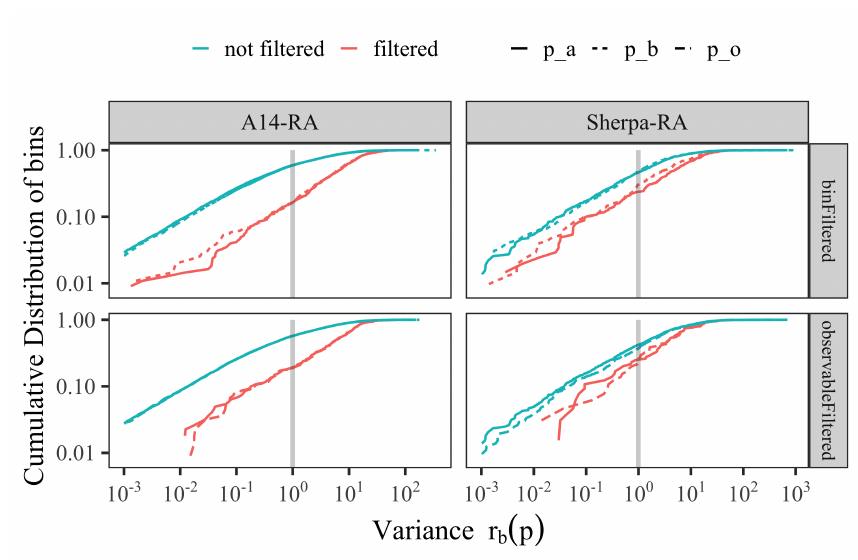
Figure 4: Cumulative distribution of bins remaining after filtering ( not filtered ) and of those filtered out ( filtered ) on the y-axis at different bands of variance levels on the x-axis. The variance level for each bin is calculated as r parameters p ∗ , which is obtained when all bins were used, and parameters p ∗ a p ∗ , which are obtained when only the bin filtered and observable filtered data are o used, respectively.